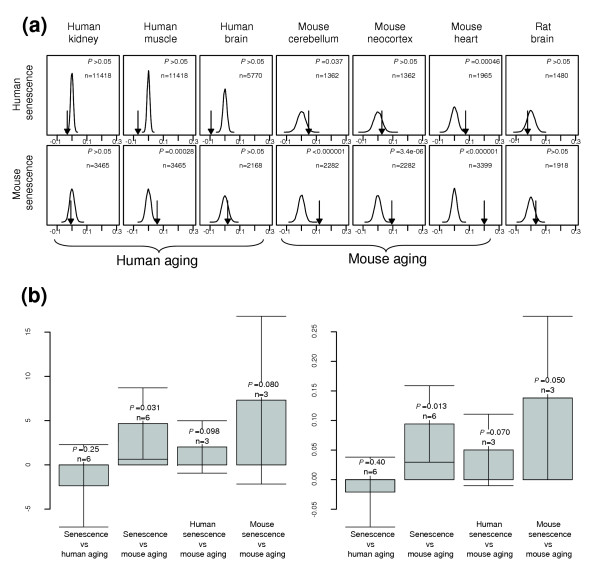
Similarity in the transcriptome signatures of senescence and mouse aging. (a) Two senescence datasets, where data derived from proliferating cells (denominator in ratio of differential expression with senescence) have been replaced by data derived from quiescent cells, are compared to seven aging datasets. Arrows represent the Pearson correlation in each comparison. Distributions of correlations produced by random pairing of genes are displayed as density curves. P values (calculated using the random correlation distributions as a reference) and numbers of gene or ortholog pairs (present in the individual comparison) are displayed in the top right part of each figure. (b) Left: analysis of the average Z-score for groups of comparisons. Only the six comparisons of senescence (mouse and human) and mouse aging (cerebellum, neocortex and heart) have a mean that passes a t test for being different from zero. Right: similar analysis of mean Pearson correlations for the same groups, producing the same result. In (b), P values and tails represent the P value for having a mean different from zero, and the 95% confidence interval for the mean, respectively.